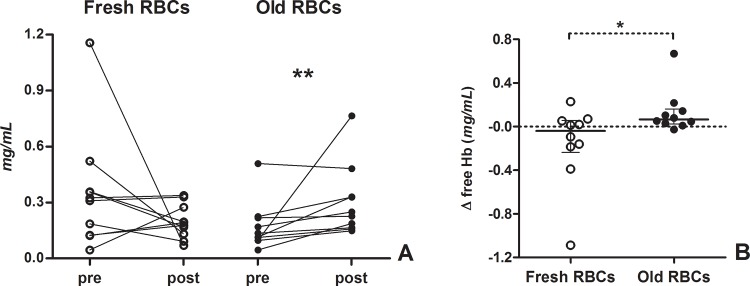
Changes in plasma free haemoglobin after blood transfusion in the two groups.(A) Individual changes in plasma free haemoglobin after blood transfusion in the two groups; **p<0.01, Wilcoxon matched-pair signed rank test. (B) Delta values (after-before transfusion) of plasma free haemoglobin in the two groups. *p<0.05, Mann-Whitney U test. Open circles indicate patients in the fresh RBC group, full circles patients in the old RBC group.